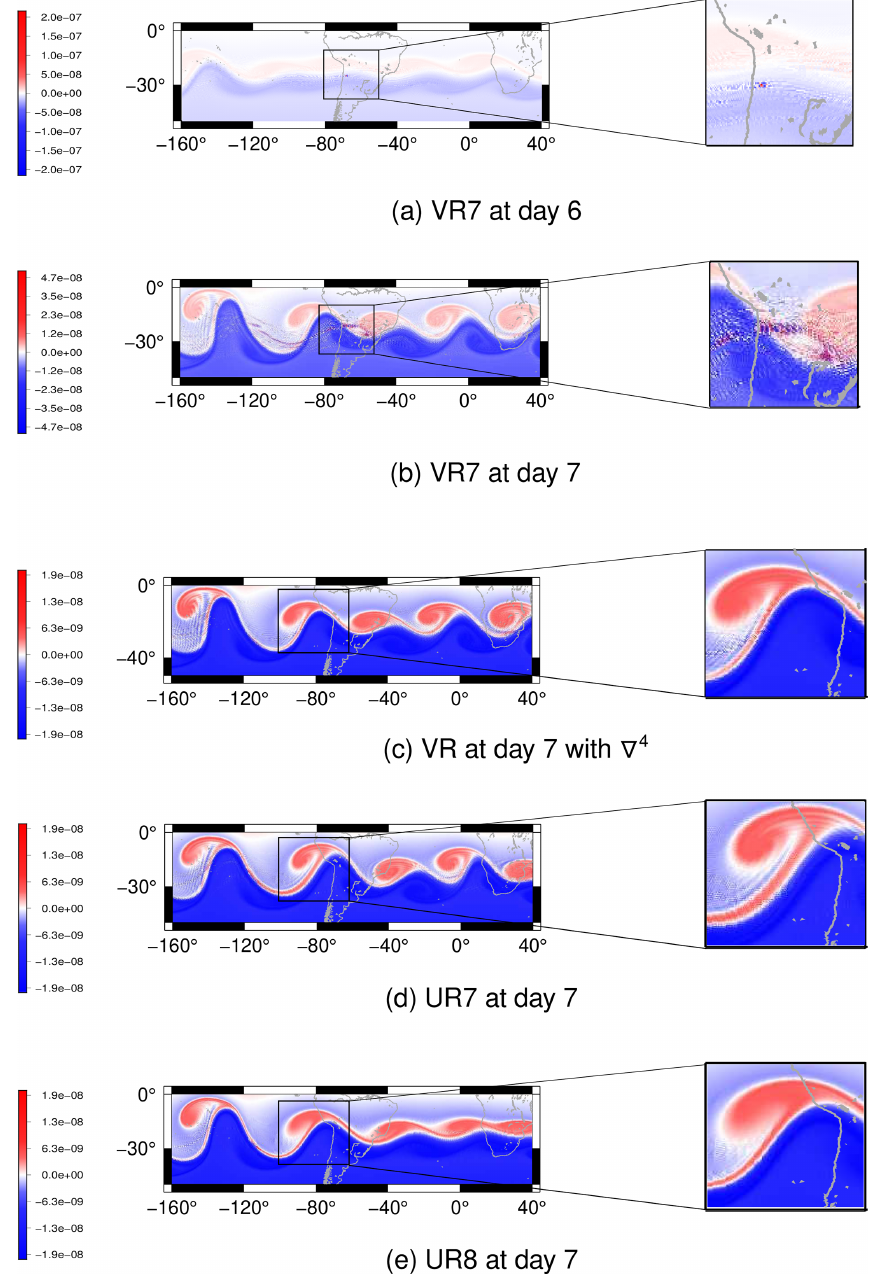
Figure 14. Barotropic unstable zonal jet for the shallow-water model: potential vorticity for the VR7 grid at (a) day 6 and (b) day 7 without fourth-order hyperdiffusion. Panel (c) shows the potential vorticity at day 7 with fourth-order hyperdiffusion in the shallow-water model for the VR7 grid. In (d) and (e) we depict the potential vorticity at day 7 for the UR7 and UR8 grids, respectively, as references.